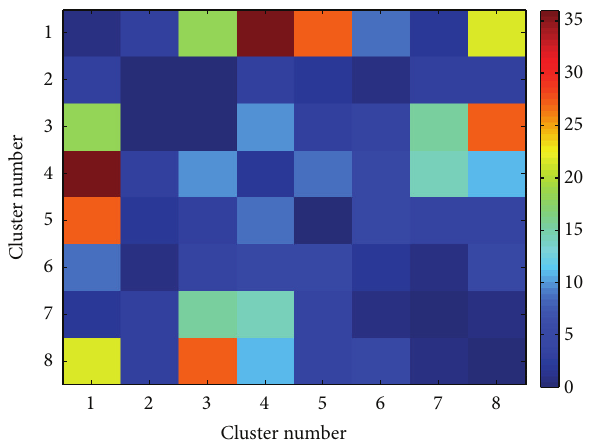
Figure 7: Categorizing the disturbed functional connectivity, which has been obtained using longitudinal statistical analysis by a mixed design ANOVA and NBS, into eight functional connectivity clusters that have been obtained using the multiview group-wise clustering method. Results show that some clusters (especially cluster number 1)aremoreinvolvedinfunctionalconnectivityalterationaftermTBI. The color-bar indicates number of involved connectomic